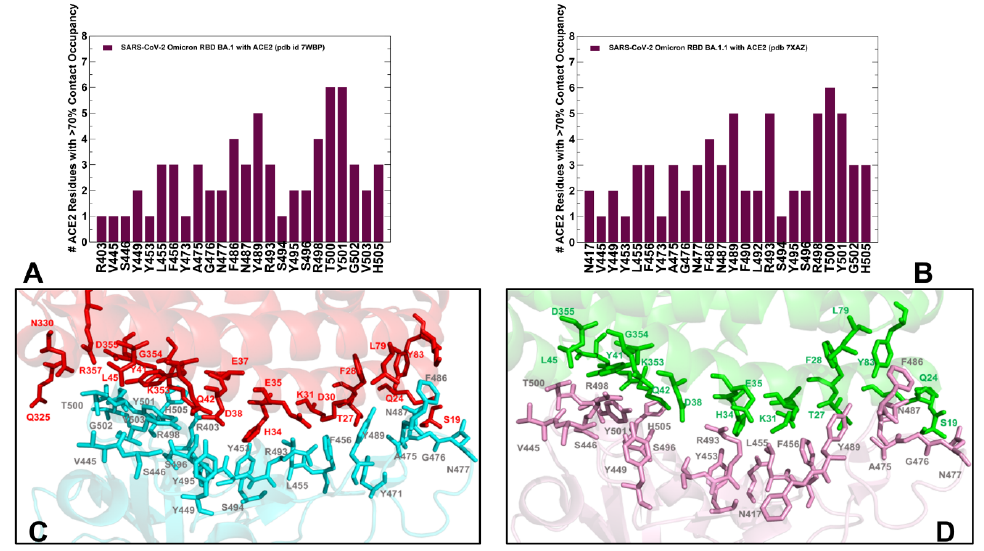
Figure 3. The distributions of the intermolecular contacts obtained by averaging results from 10 independent MD simulations of the Omicron RBD BA.1 and BA.1.1 complexes with hACE2. The ensemble-average number of distinct hACE2 residues making stable intermolecular contacts (>70% occupancy) with the RBD residues obtained from MD simulations of the RBD BA.1-hACE2 complex, pdb id 7WBP ( A ) and the RBD BA.1.1-hACE2 complex, pdb id 7XAZ ( B ). Structural mapping of the intermolecular RBD BA.1-hACE2 interface. The RBD binding residues are shown in cyan sticks and the hACE2 binding residues are in red sticks ( C ). Structural mapping of the intermolecular RBD BA.1.1-hACE2 interface ( D ) The RBD binding residues are shown in cyan sticks and the hACE2 binding residues are in green sticks. The intermolecular binding interface residues are annotated.